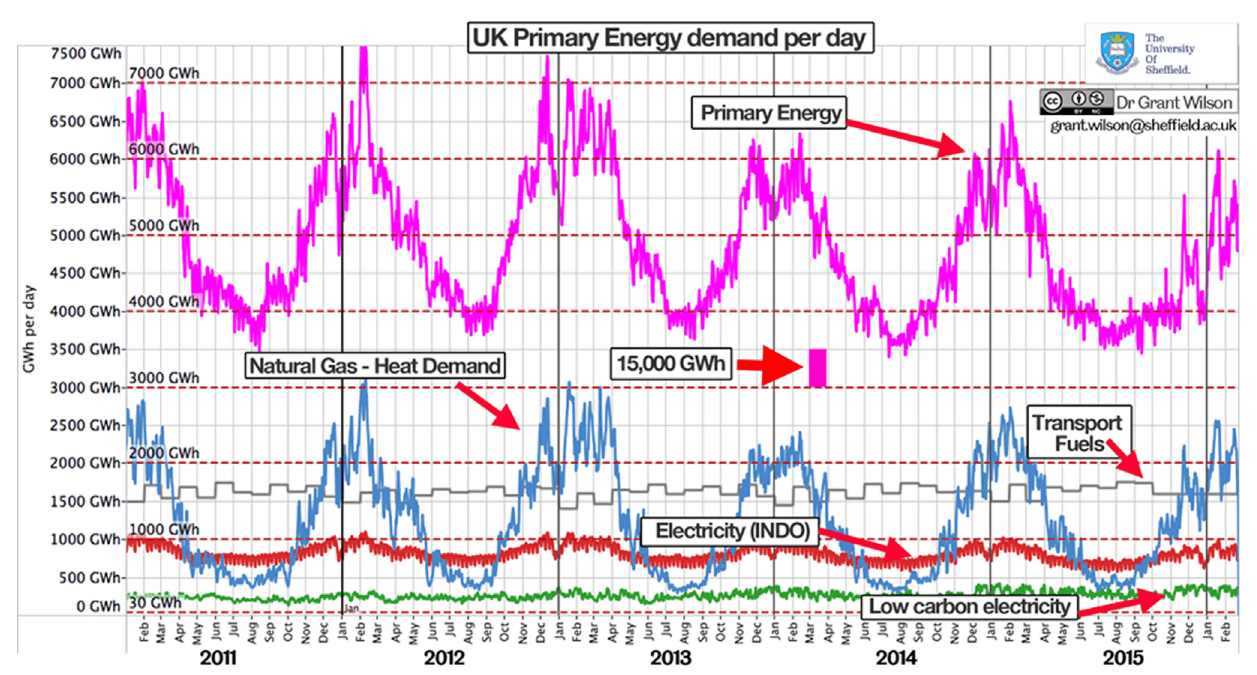
FiGUre 5 | saed with primary energy demand and low-carbon electricity added for scale